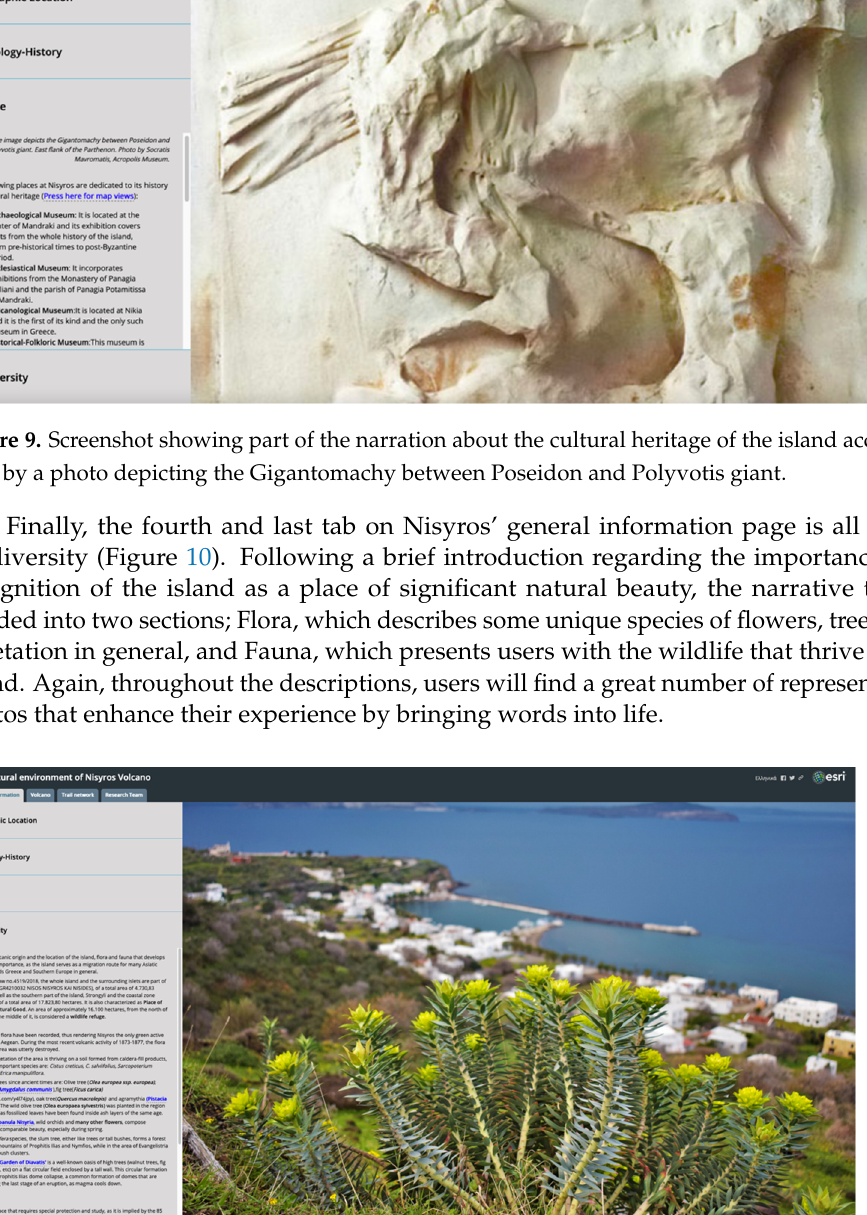
Figure 8 . Screenshot showing the second horizontal tab of the general information category,